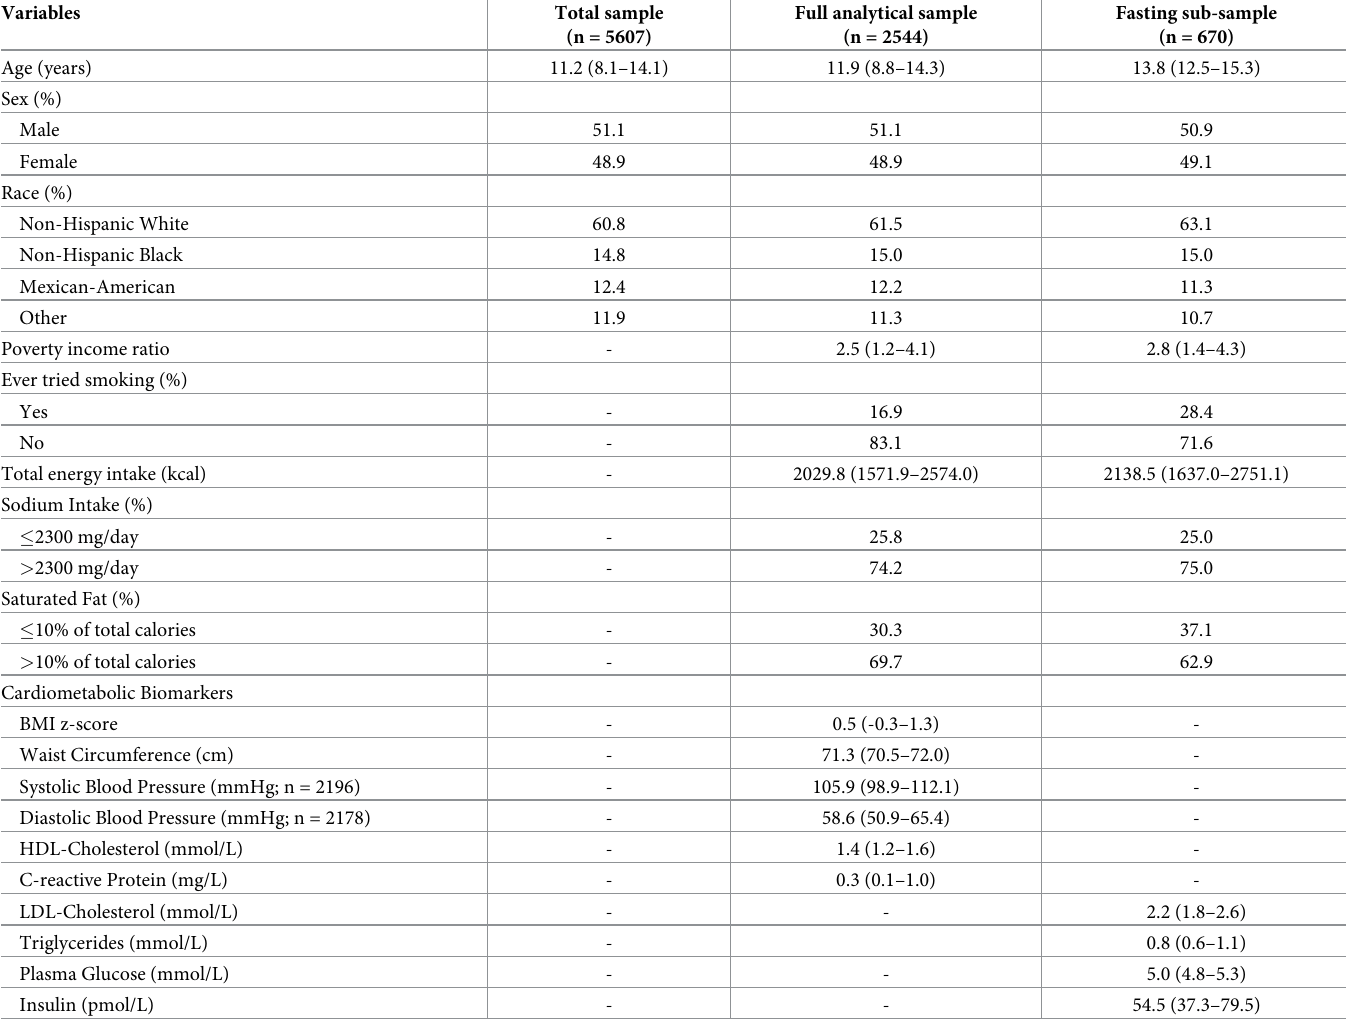
Table 1. Weighted participant characteristics of the 2003/04 and 2005/06 cycles of the